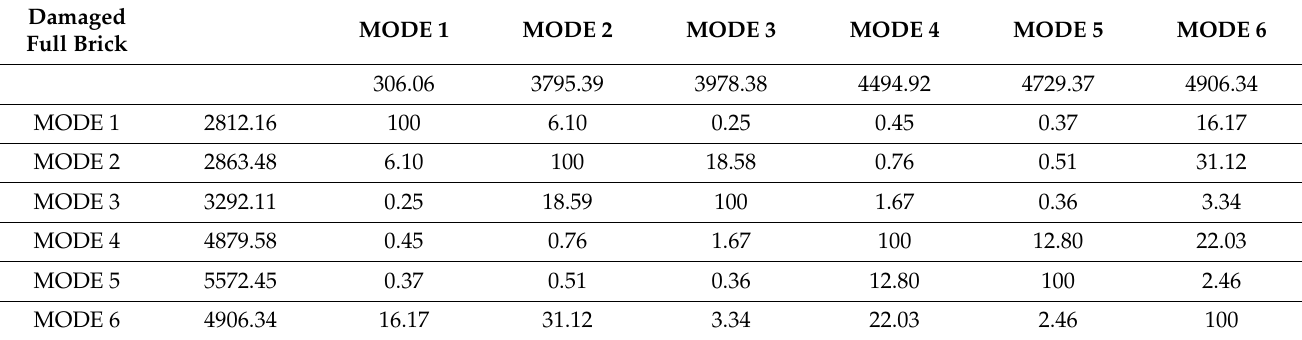
Table 3. The result of the validation (AutoMAC) in tabular form for the damaged full ceramic brick.